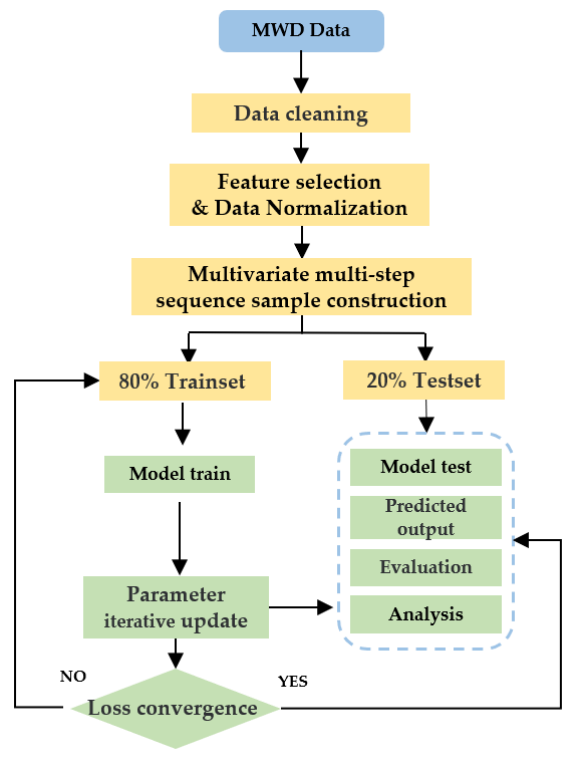
Figure 6. Process of BHP output forecasting.